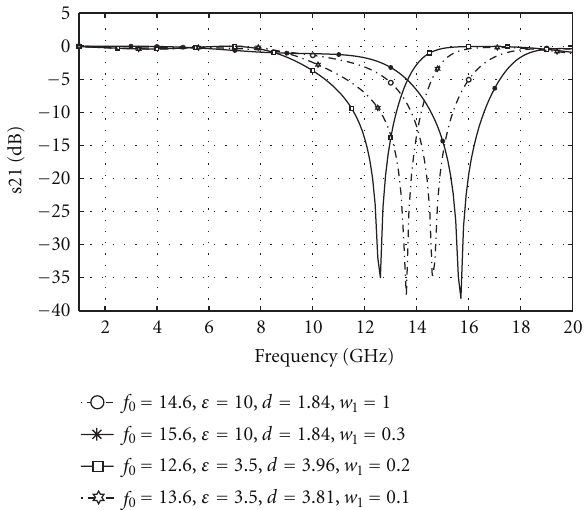
Figure 13: The transmission coe ffi cient frequency response of the T-junction in (Figure 12) producing transmission zeros at several